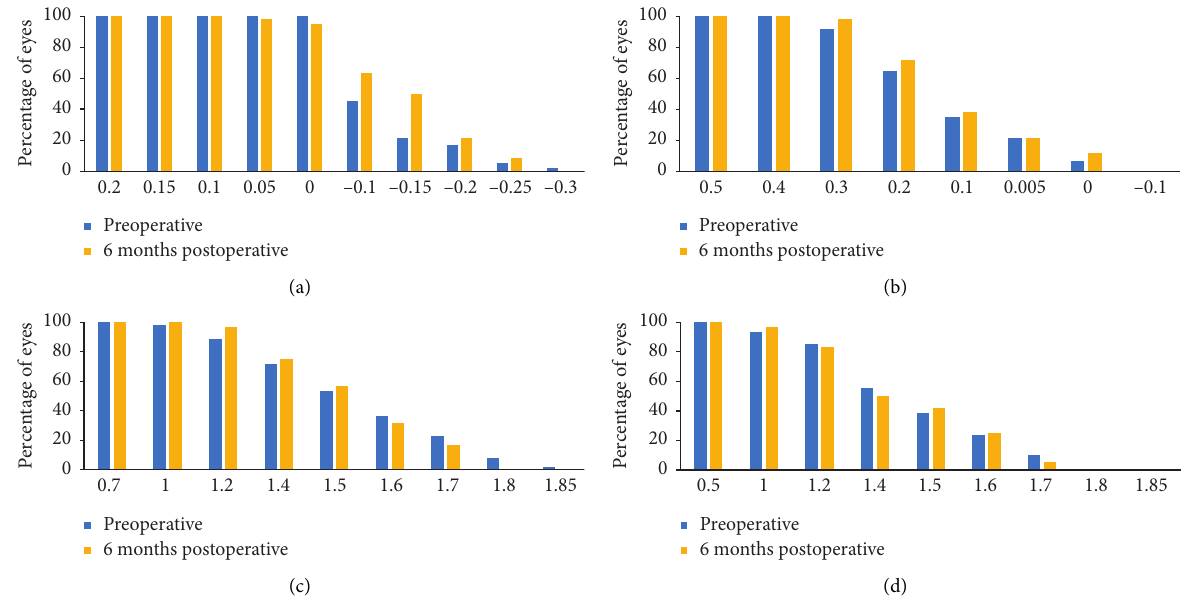
Figure 11: Changes in 90% contrast (a) and 10% (b) uncorrected distance visual acuity and uncorrected contrast sensitivity (c) and uncorrected contrast sensitivity with glare (d) at 6 months of follow-up after